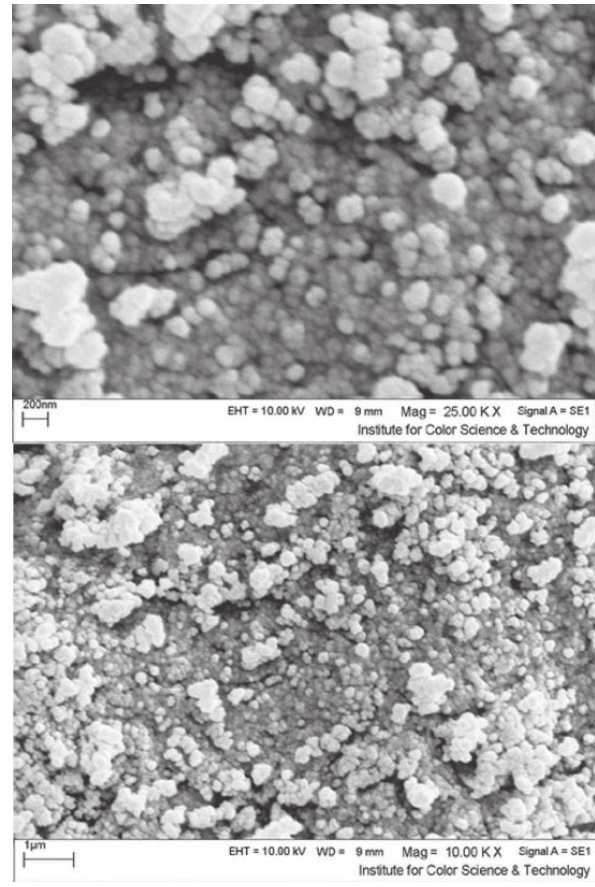
Fig. 3: SEM images of the sample no. 1 (without